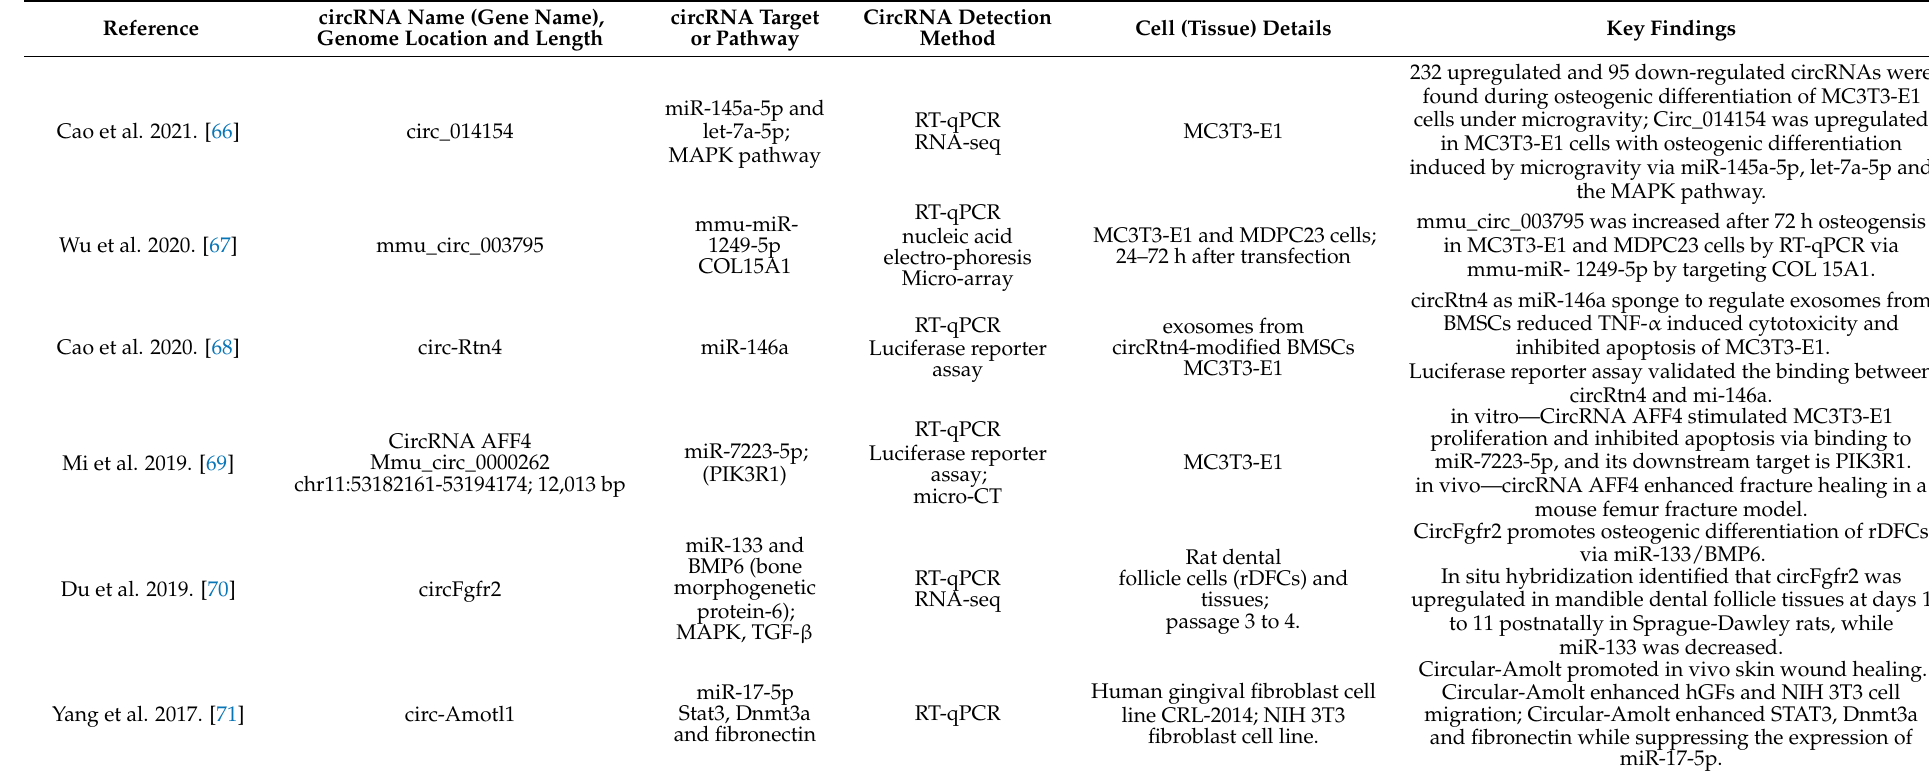
Table 4. CircRNAs in MC3T3-E1 cells, rDFCs, and GFs cell